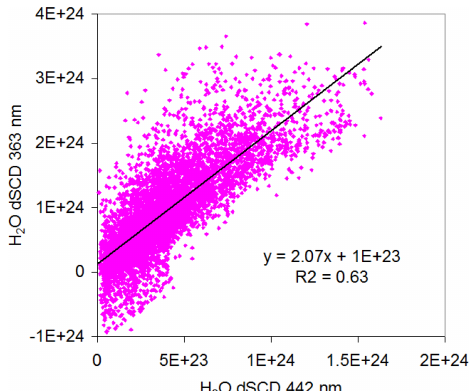
Figure A2. Correlation plot of the H 2 O dSCDs retrieved at 363nm versus those retrieved at 442nm for the whole ship cruise. The re- gression line is fitted assuming that the H 2 O dSCDs retrieved at 442nm have no